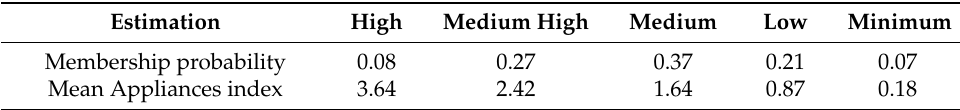
Table 1. Size of latent classes and mean of appliances index.